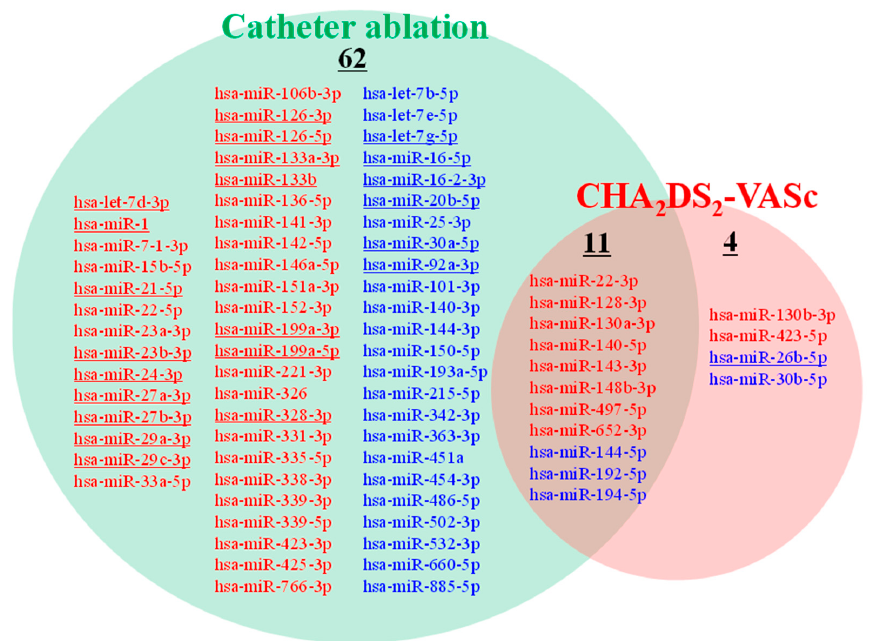
Figure 1. Circulating miRNAs whose plasma levels were correlated with CHA 2 DS 2 -VASc score and/or CA. miRNAs whose plasma levels showed positive ( red letters ) or negative ( blue letters ) correlation with CHA 2 DS 2 -VASc score ( q < 0.1) are presented in the red circle. miRNAs whose plasma levels showed positive (blue letters) or negative (red letters) correlation with CA operation ( q < 0.1) are presented in the green circle. Underlined miRNAs are reported to be cardiac-enriched miRNAs [21]. Forty-six and twenty-seven miRNAs showed significant increase and decrease in the patients who did not undergo CA compared to those who underwent CA. Eleven miRNAs were commonly identified as both CHA 2 DS 2 -VASc- and CA-associated miRNAs. Plasma levels (i.e., −∆ C q value for each miRNA) of these 11 miRNAs are presented as heat map (Figure 2) and as dot plots (Figure 3). Eight miRNAs (i.e., hsa-miR-22-3p, hsa-miR-128-3p, hsa-miR-130a-3p, hsa-miR-140-5p, hsa-miR-143- 3p, hsa-miR-148b-3p, hsa-miR-497-5p, hsa-miR-652-3p) tended to show higher plasma levels in patients with high CHA 2 DS 2 -VASc scores and lower plasma levels in patients who underwent CA (Figure 2A). Three miRNAs (i.e., hsa-miR-144-5p, hsa-miR-192-5p, hsa-miR-194-5p) tended to show lower plasma levels in patients with high CHA 2 DS 2 -VASc scores and higher plasma level in patients who underwent CA. Hierarchical clustering analysis on plasma miRNA levels (i.e., −∆ C q of the miRNAs) classified the patients into two classes (Figure 2B), where patients with high risks (i.e., high CHA 2 DS 2 -VASc score and/or without CA operation) tended to be classified into Class 2, and patients with low risks (i.e., low CHA 2 DS 2 -VASc score and/or with CA operation) tended to be classified into Class 1. In addition to CHA 2 DS 2 -VASc score, we also investigated if there existed miRNAs whose plasma levels showed significant correlations to HAS-BLED score, which is clinically useful for predicting bleeding risk of AF patients [22], but it turned out that no such miRNAs existed in the present study.